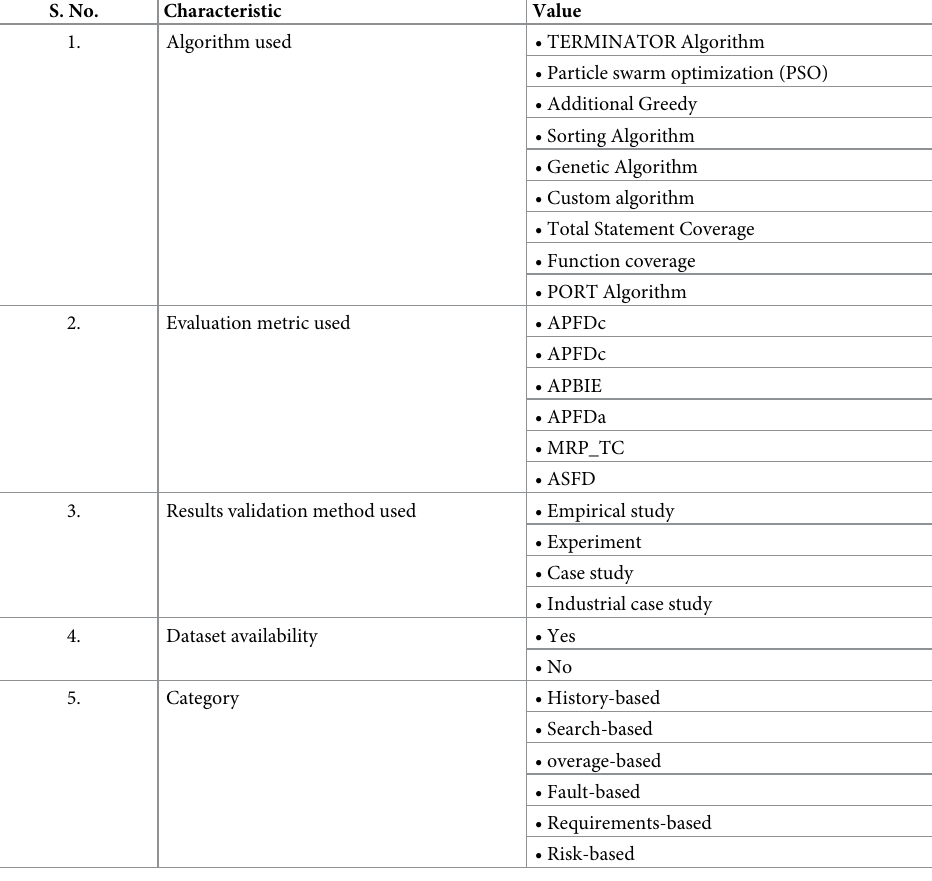
Table 6. Data extraction